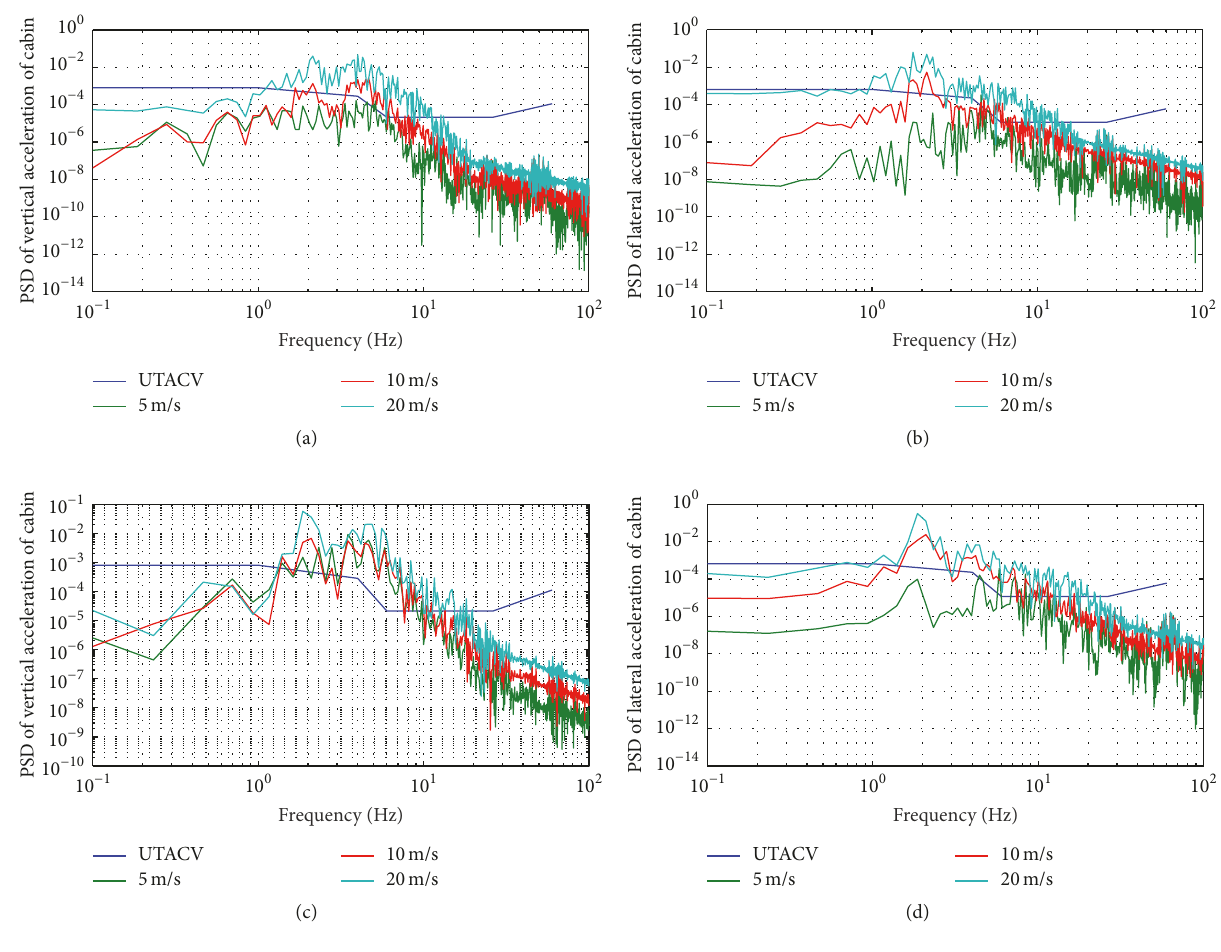
Figure 25: Power spectral density of cabin acceleration and the UTACV criteria: (a) vertical acceleration (vehicle speed = 40km/h), (b) lateral acceleration (vehicle speed = 40 km/h), (c) vertical acceleration (vehicle speed = 100km/h), and (d) lateral acceleration (vehicle speed =